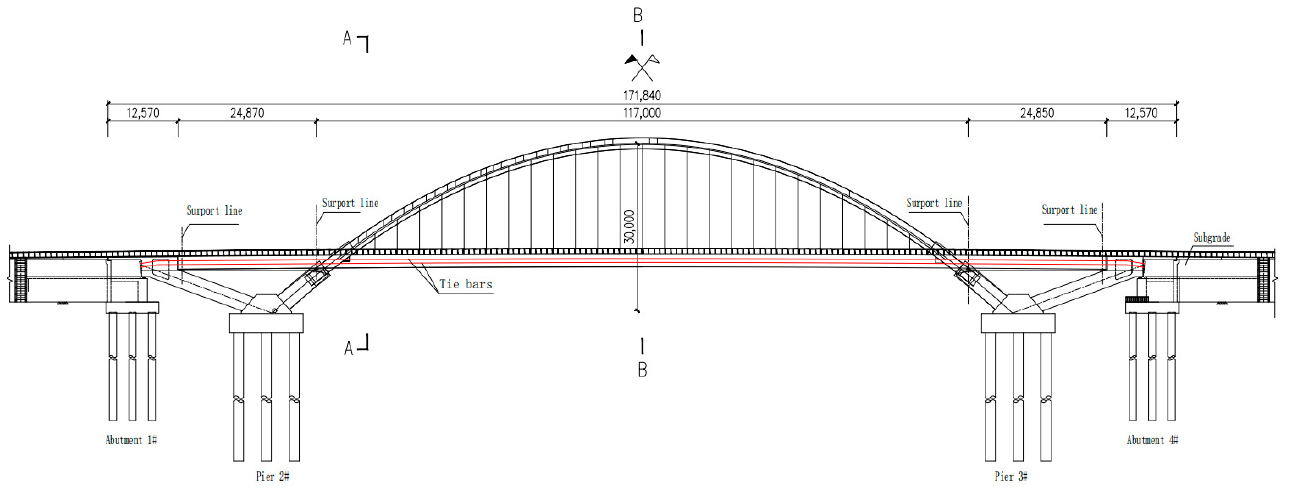
Figure 3. Cross-section of the bridge (unit: mm).